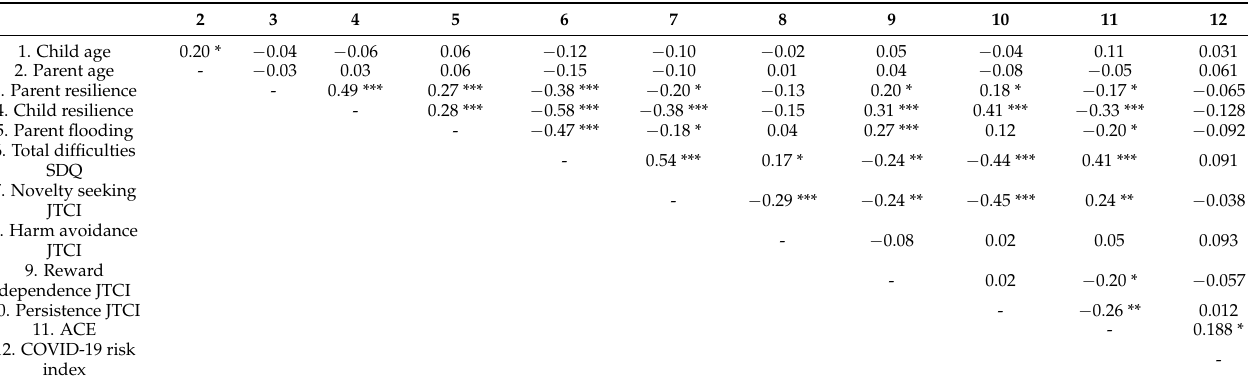
The results of the regression analysis on the whole sample are shown in Table 3 (coefficients are presented as standardized beta). ANOVA confirmed that the fifth and final model explained 64% of the variance ( R 2 = 0.640, F (9, 148) = 29.29, p < 0.001). Reward dependence, persistence, exposure to COVID-19-related risk factors, and parental resilience did not predict SDQ total difficulties. Significant predictors were low child resilience, high novelty seeking and harm avoidance, ACEs, and high levels of parental